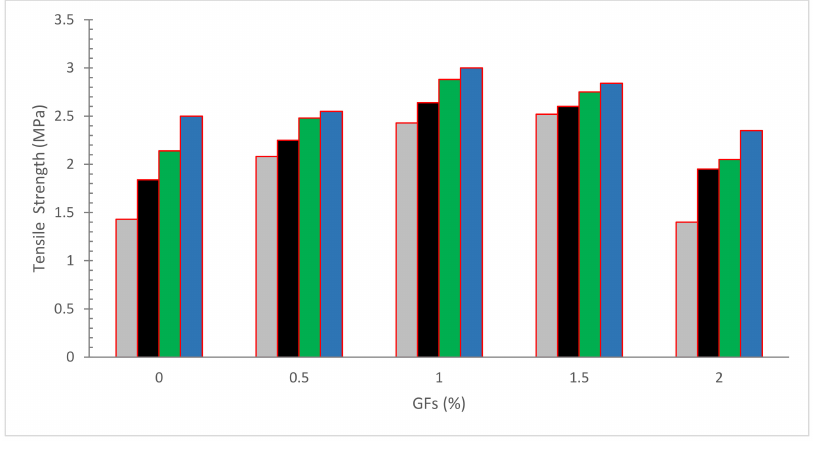
Figure 7. Tensile strength: Data source [54]. Table 2. Summary of Fresh and Mechanical performance of concrete with Glass Fibers